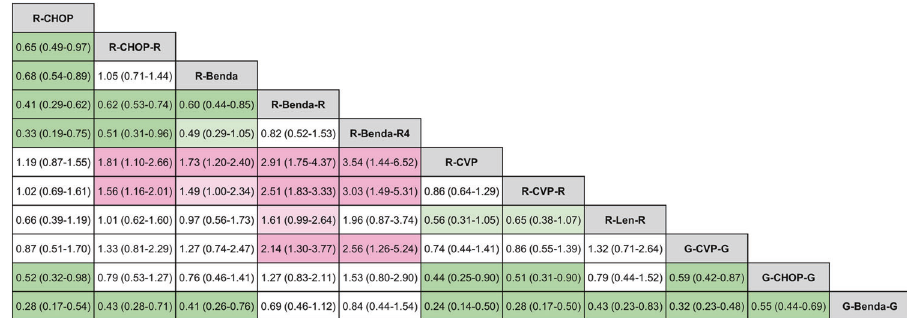
Fig. 3 League table of network meta-analysis results. Direct and indirect comparisons of PFS of different regimens were shown. The table should be read from left to right. Hazard ratios for comparisons are in the cell in common between the column-de fi ning and row-de fi ning treatment. A hazard ratio of <1 favors row-de fi ning